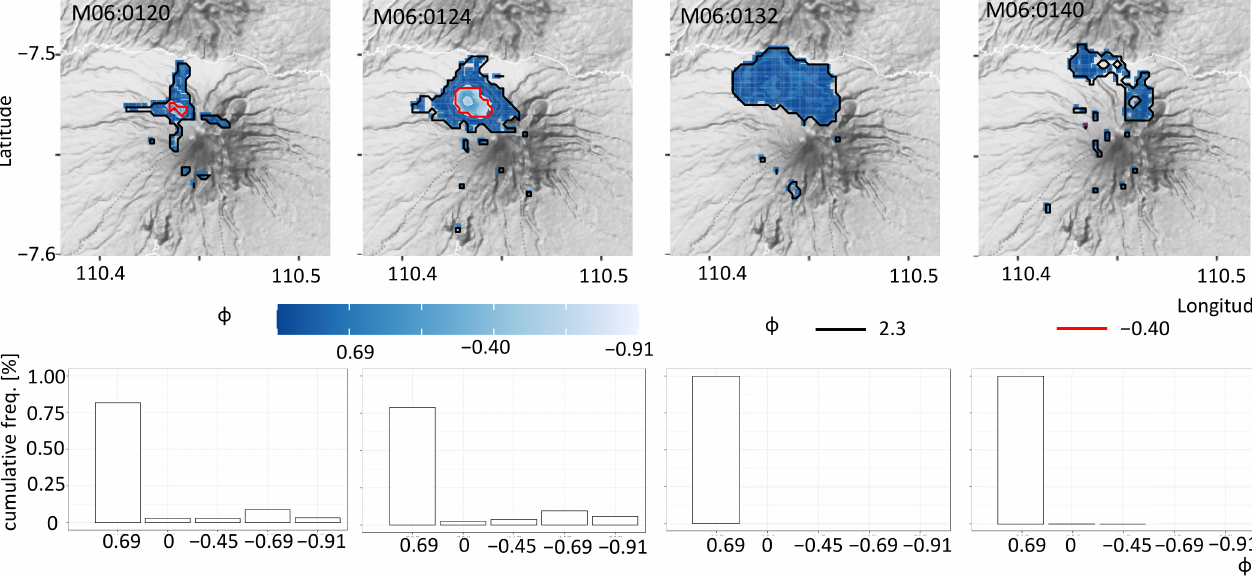
Figure 4. The first row is the spatial distribution of the estimated radar-retrieved mean diameter of M06 at several time stamps. The second row is the corresponding cumulative grain size for each time stamp. In each image on the second row, the x -axis is the lower limit of φ = − log 2 D